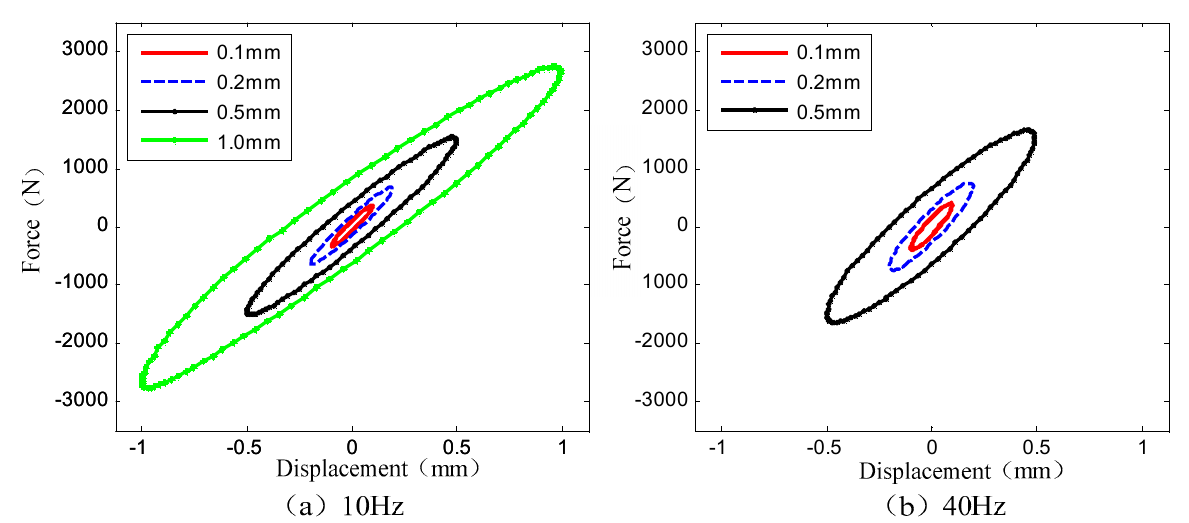
Figure 8. The hysteresis curves of specimen Y01-03 at the same frequency with different displacements: ( a ) 10 Hz, ( b ) 40 Hz.